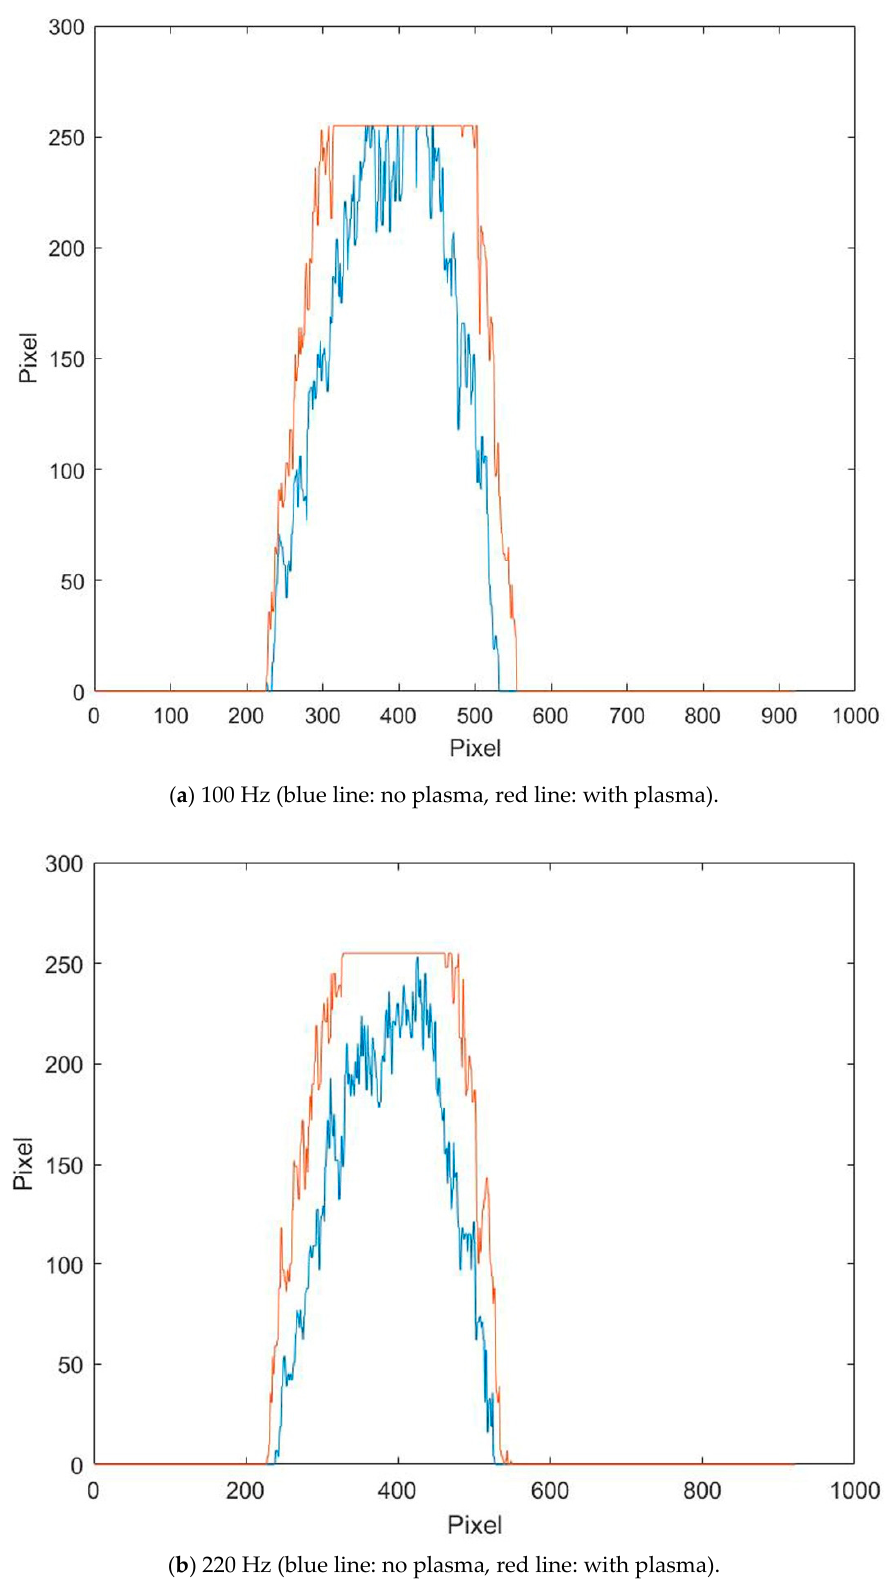
Figure 9. Two-dimensional cross-sectional view of OH-PLIF light intensity signal.